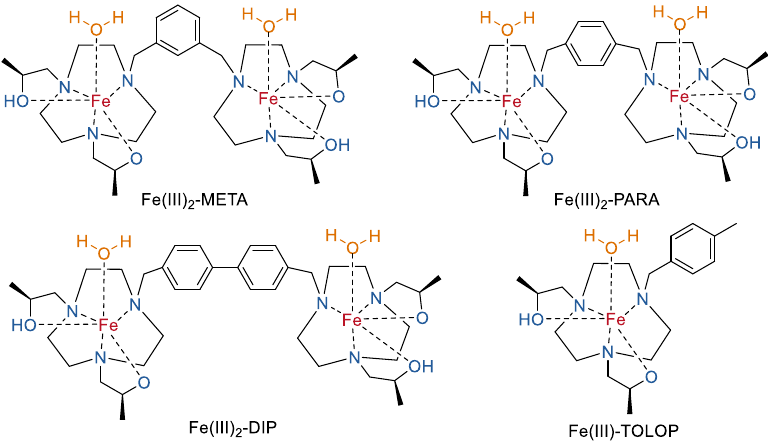
Figure 10. Chemical structures of dinuclear Fe(III) complexes based on TACN. A reference mononuclear complex (Fe(III) – TOLOP) was also shown [66].